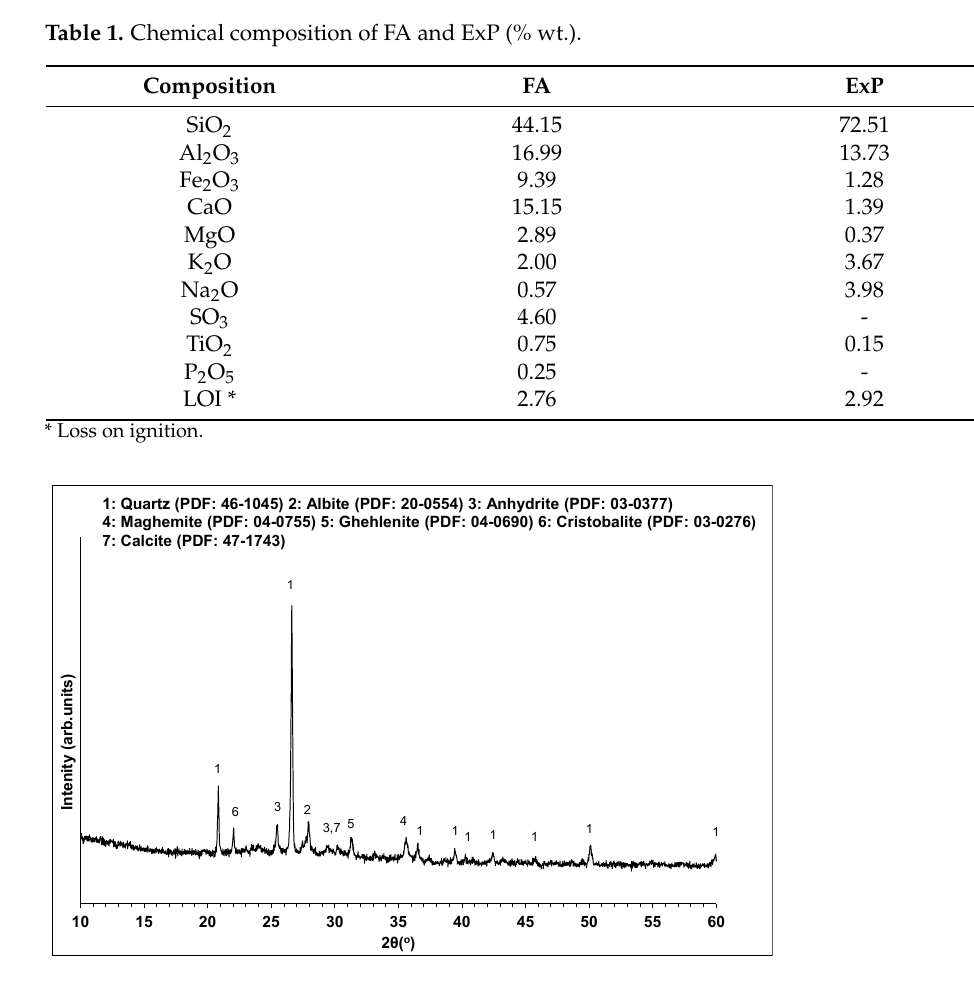
Figure 2. Mineralogical composition of FA.